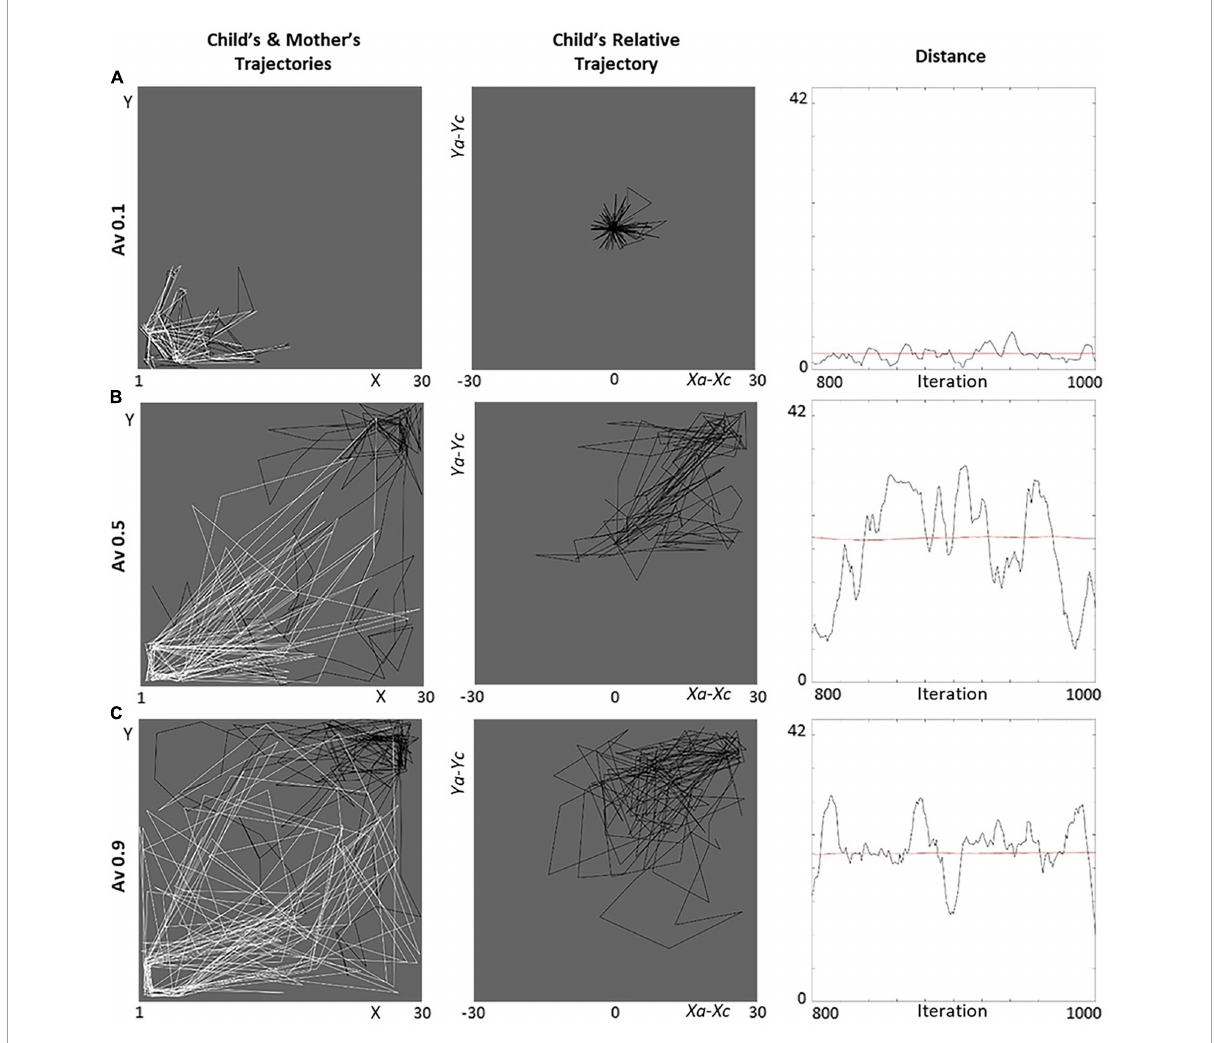
FIGURE8 Behavior of avoidant dyads for different dimensional levels. Three avoidant levels represent the (A) “anti-avoidant” ( A v = 0 . 1), (B) secure ( A v = 0 . 5), and (C) (extremely) avoidant ( A v = 0 . 9) cases in terms of the agents’ trajectories (black for the child, white for the mother), child’s trajectory relative to mother, and distances (smoothed with a moving filter). In the left-column pictures, the objects of interest for child and mother are located in the top-right and bottom-left corners, respectively. All graphs refer to iterations 800–1,000 (the last 200 of our simulations).